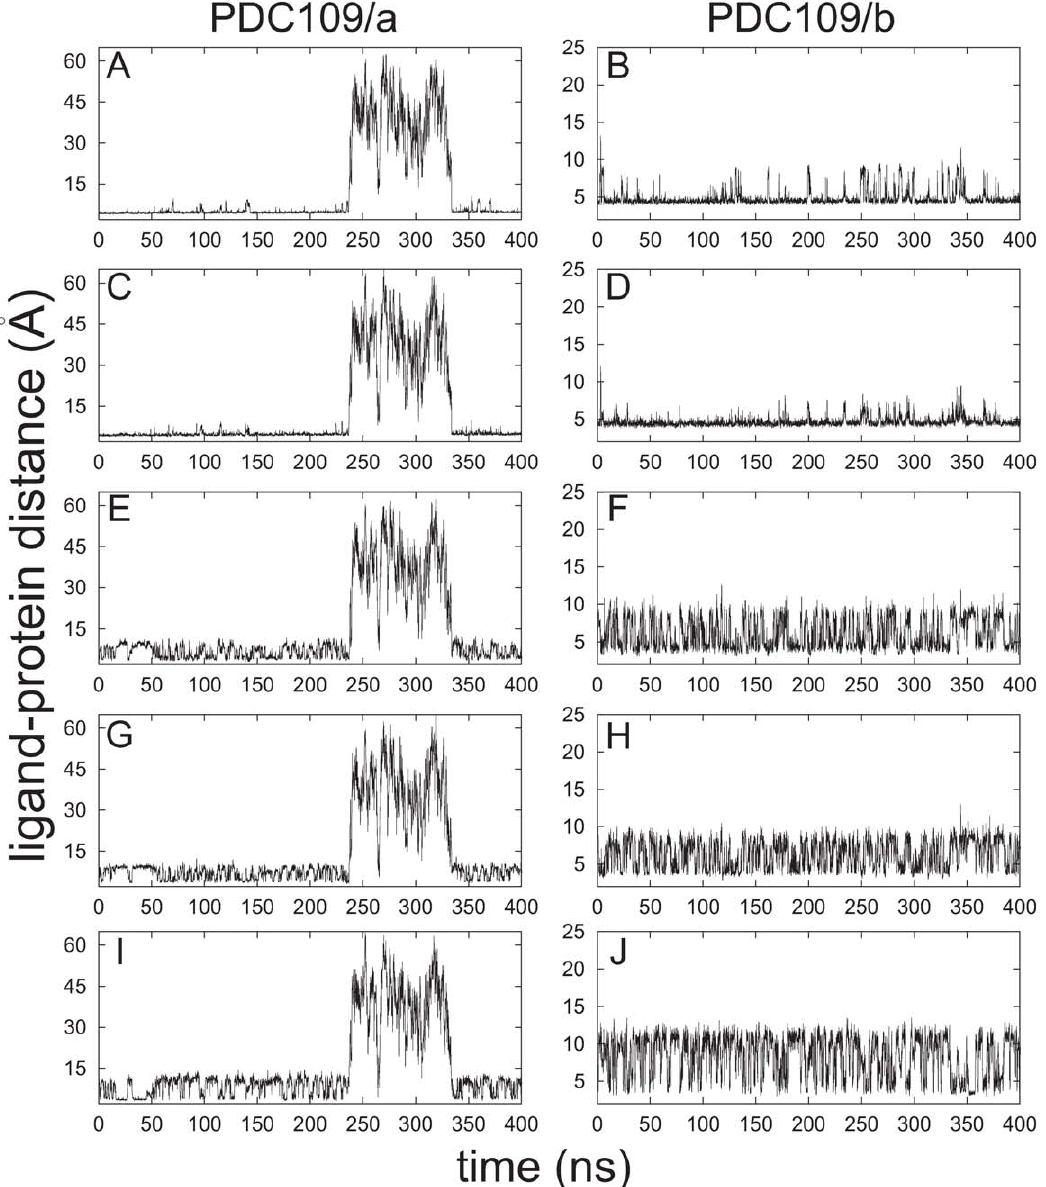
Figure 3. Distances between the ligand and protein interaction sites in PDC109 domains. Time series are shown for distances between the quaternary ammonium nitrogen of PhC and the center of geometry of six carbon atoms in indole rings of W47 (A), W93 (B), W58 (C), W106 (D); and between the average position of anionic PhC phosphoryl oxygens and the hydroxyl oxygens of Y30 (E), Y75 (F), Y54 (G), Y100 (H), Y60 (I), Y108 (J).